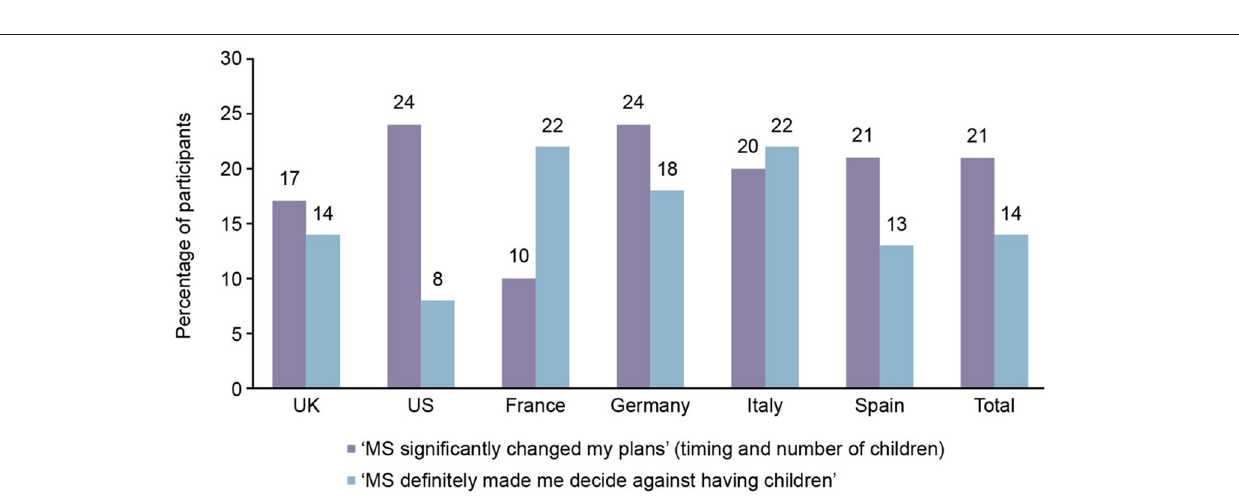
Frontiers in Neurology | www.frontiersin.org